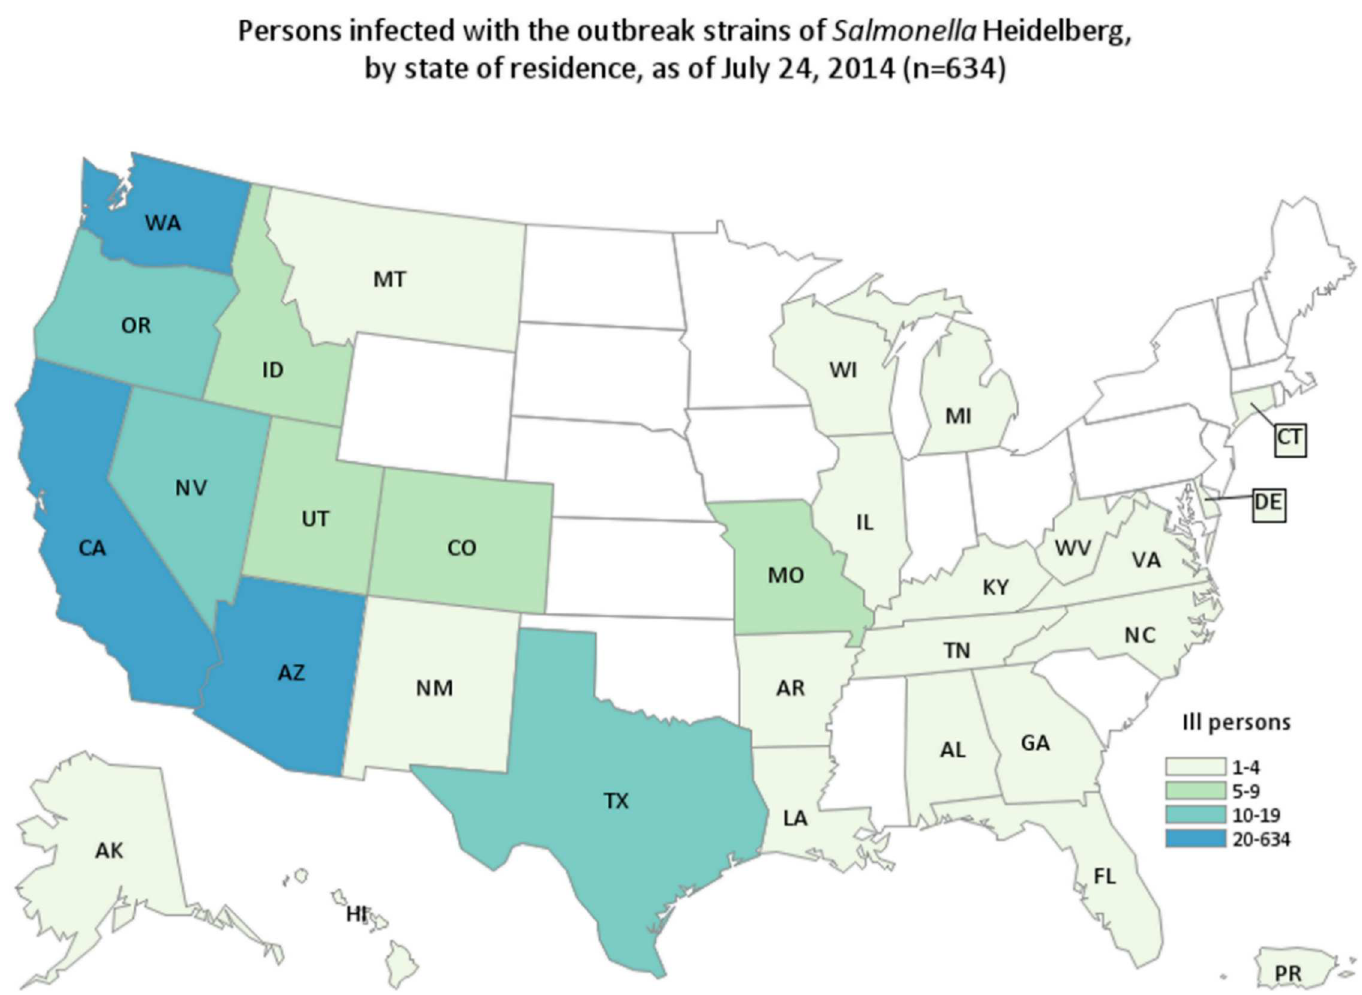
Fig 1. Persons Infectedwiththe Outbreak Strainsof Salmonella Heidelberg, by Week of IllnessOnset,March 2013-July 2014.